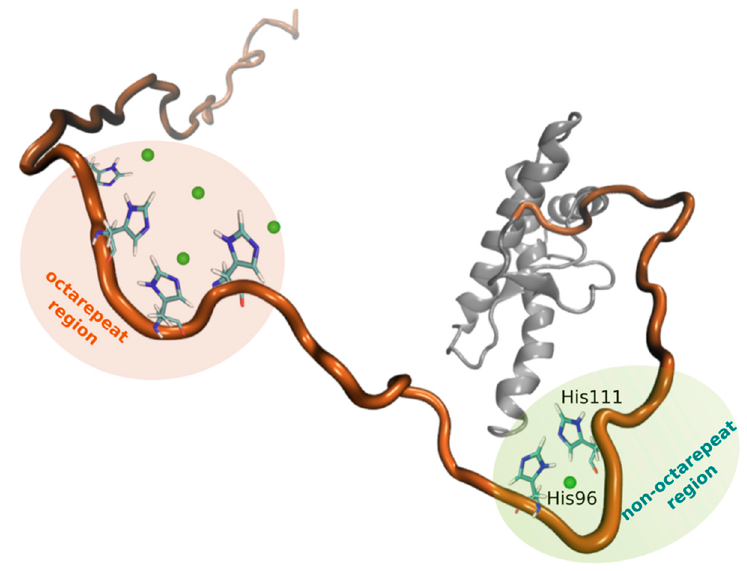
Figure 1. Cartoon representation of the secondary PrP C structure. The globular domain is shown in grey, the N-terminal region in orange. The octarepeat and non-octarepeat regions are highlighted in orange and green, respectively, with histidine residues binding copper ions (in green).